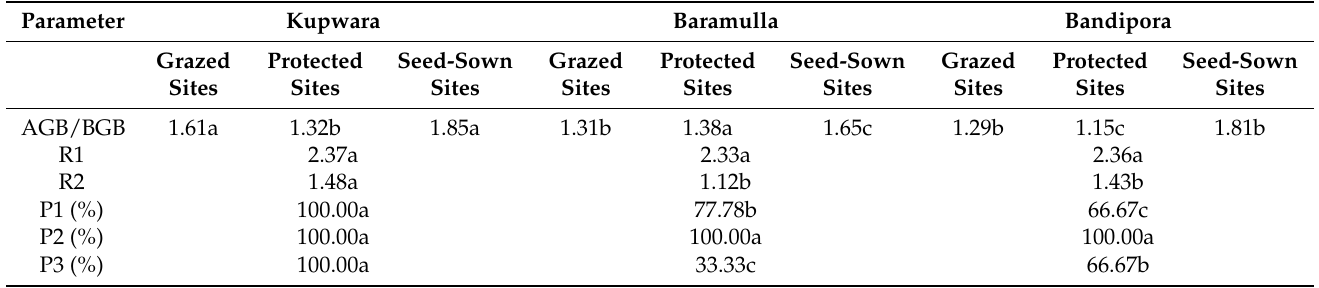
Table 1. Comparison between northern Kashmir districts in terms of biomass production.